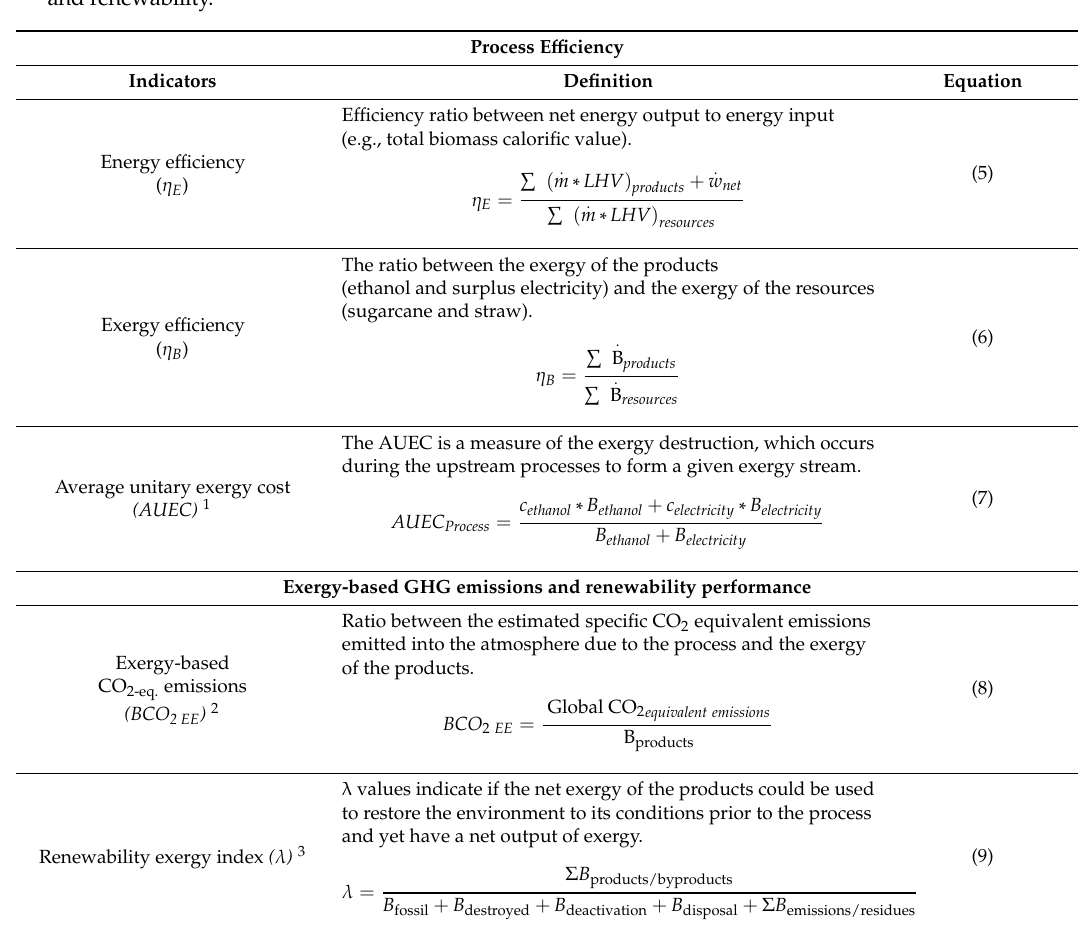
Table 1. Key performance indicators for process efficiency, exergy-based greenhouse gas (GHG) emissions, and